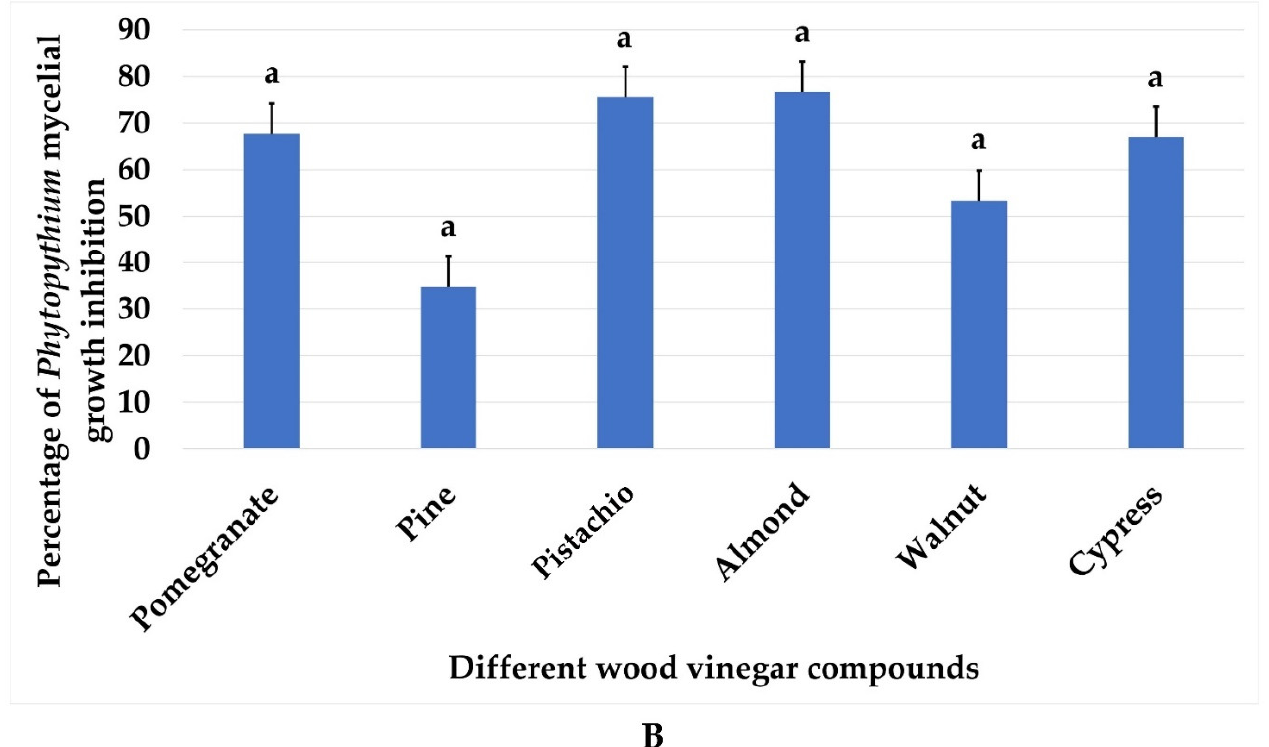
Figure 5. ( A ) Bar chart comparing of different wood vinegar dilutions against mycelial growth of Phytopythium sp. (ON409943). ( B ) Percentage of mycelial growth inhibition of Phytopythium sp. by different wood vinegars used in this study. Bars labeled with different letters represent significant differences among the treatments at p < 0.05 using Tukey’s HSD test.